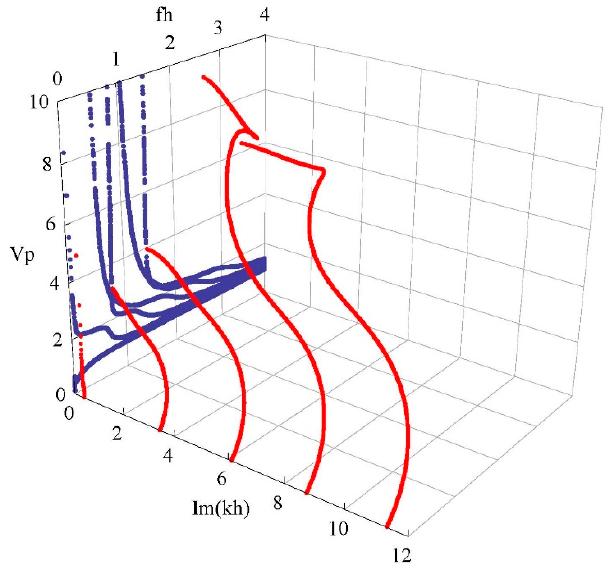
Figure 7. Phase velocity dispersion and attenuation curves of a Lamb-like wave; propagating wave in blue; non-propagating wave in red.